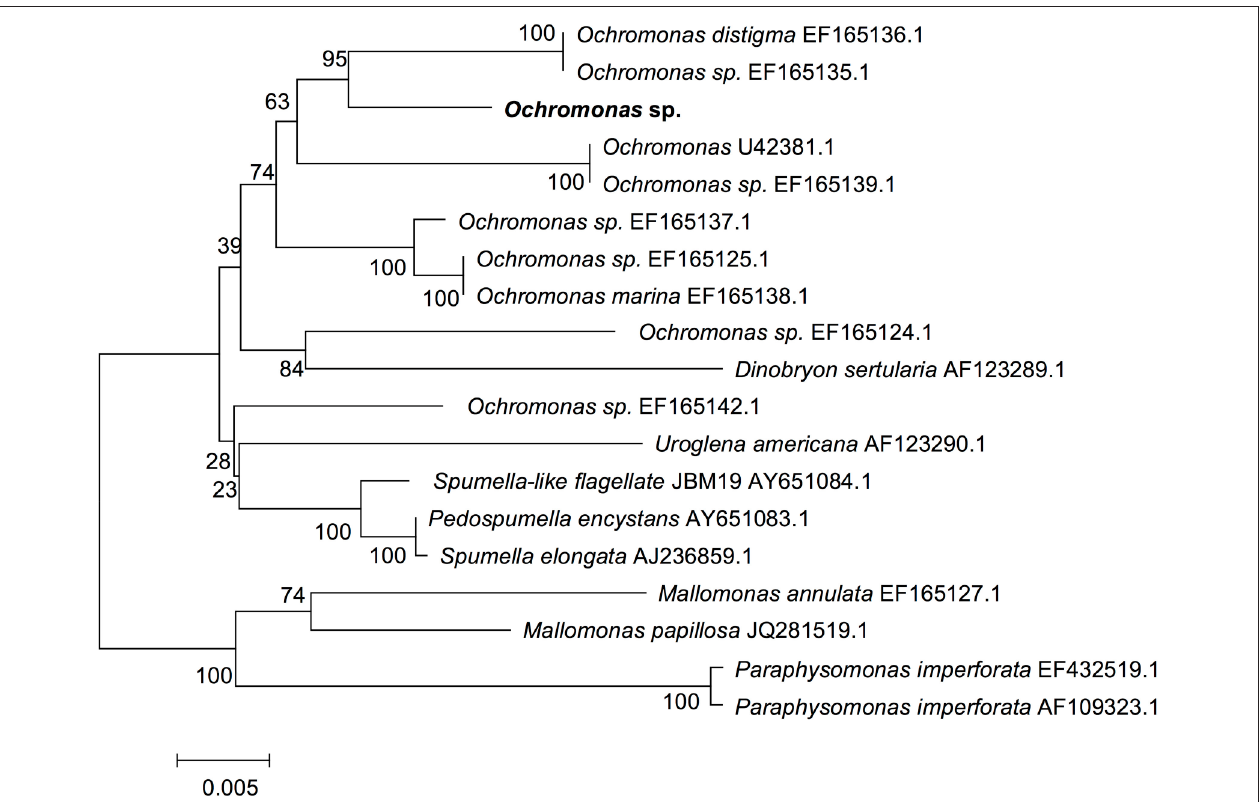
FIGURE 2 | Phylogenetic tree of the flagellate based on 18S rRNA gene sequence. Phylogenetic tree based on comparison of the 18S rRNA gene sequences indicating that this flagellate (in bold) belongs to Ochromonas . The phylogenetic tree was generated using the neighbor-joining method. Bootstrap values, expressed as percentages of 1000 replications, are given at the branching points. The scale bar indicates substitutions per nucleotide